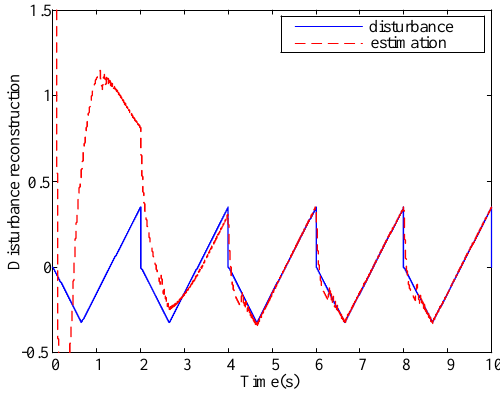
Figure 10. Discontinuous input recovery by PIO.